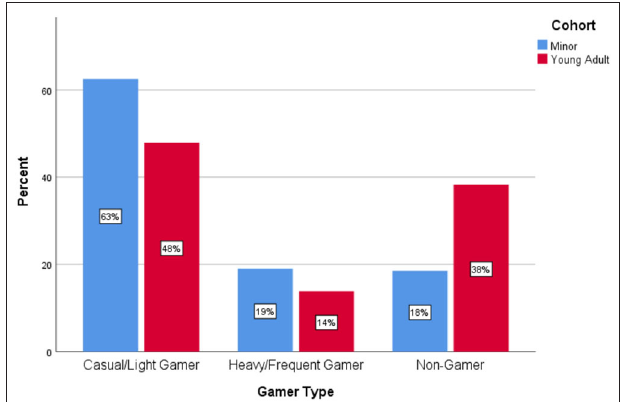
FIGURE 1 | Percentage of gamer types in each cohort.